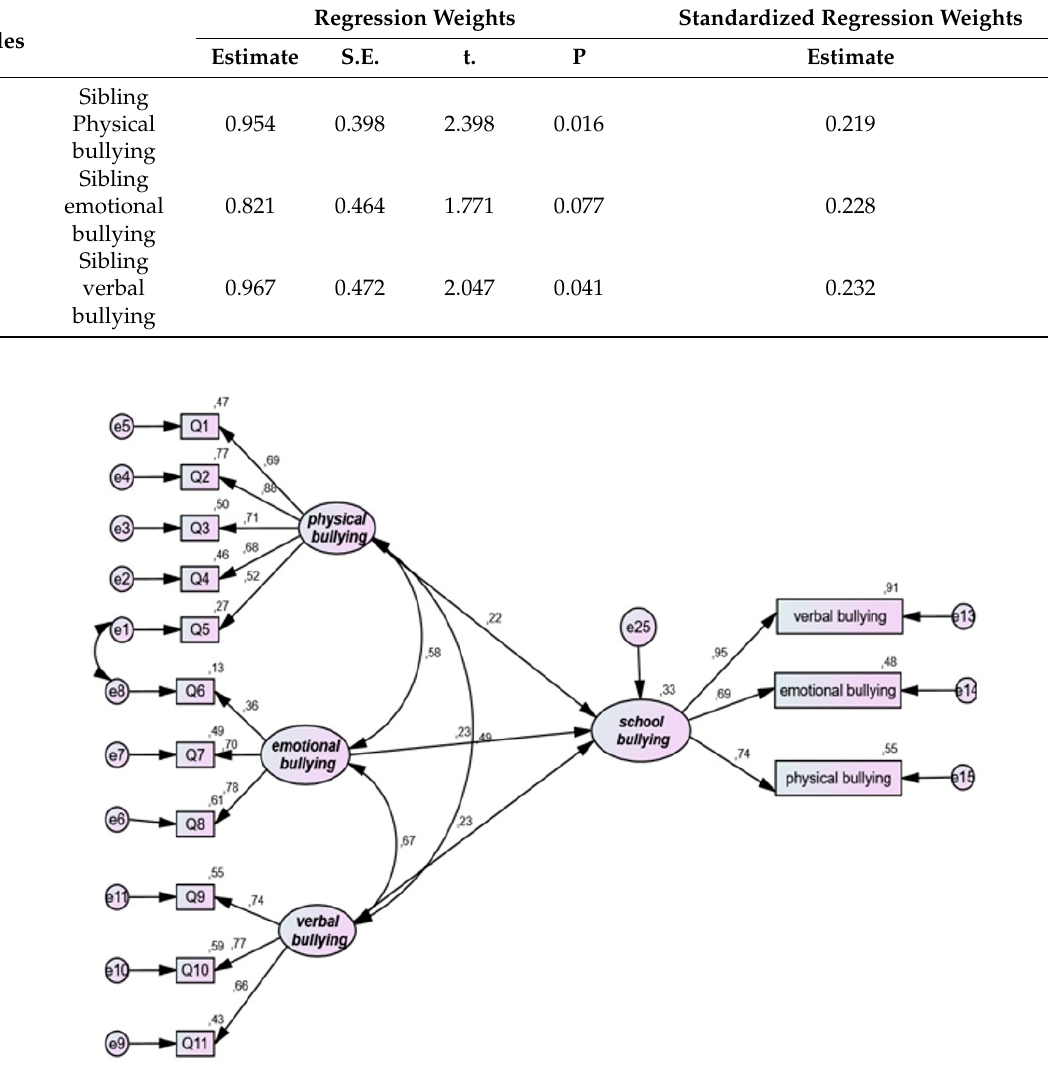
Figure 2. Structural model for research question 2. Note the structural equation modeling links be ‐ tween physical, emotional, and verbal bullying by brothers (the bullying) as an independent varia ‐ ble and school bullying as a dependent